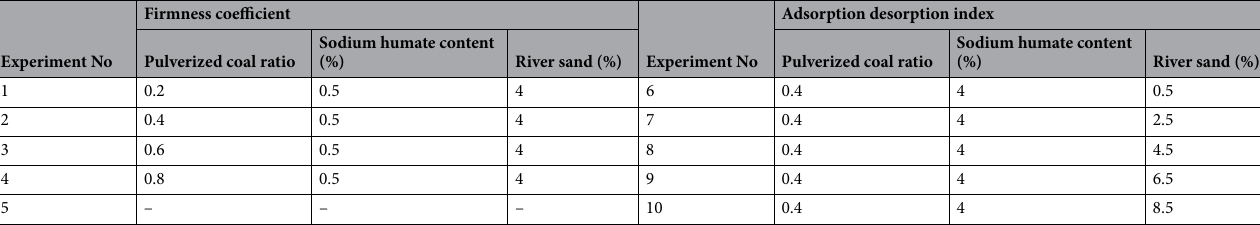
Table 4. Ratio table of firmness coefficient, adsorption and desorption index of similar materials.